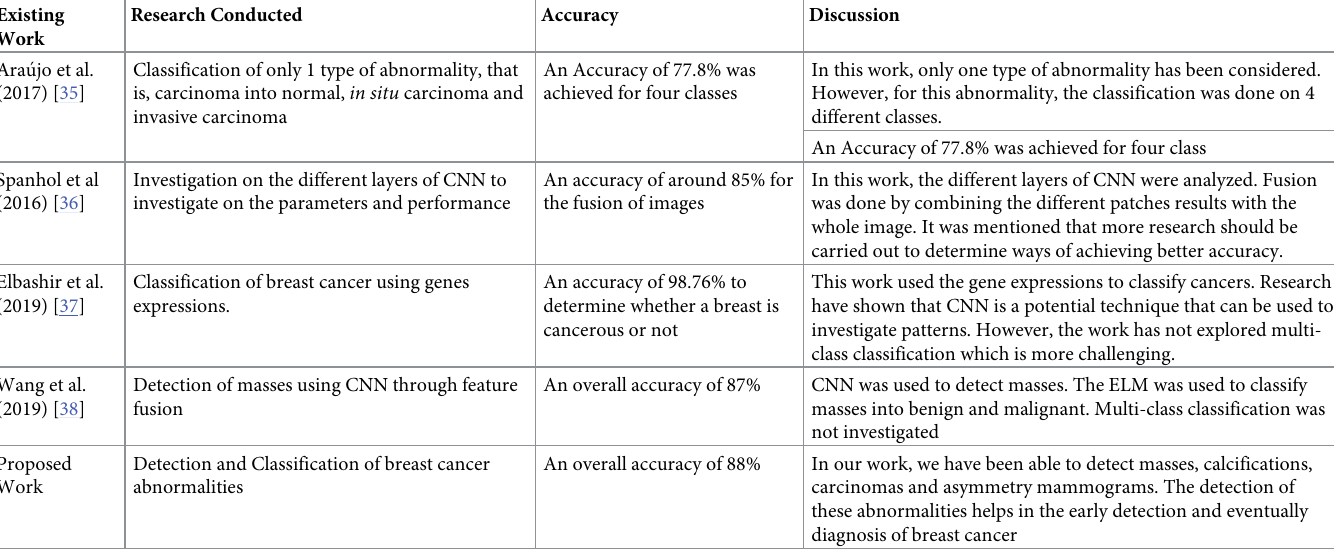
Table 3. Summary of comparison of proposed model with existing